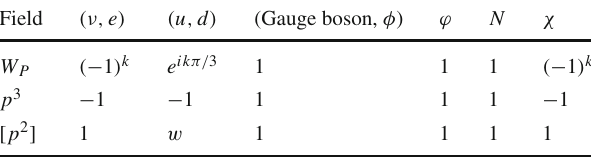
Table 1 Field representations under the residual symmetry, where the W P value of a fermion does not depend on its left or right chirality and generation